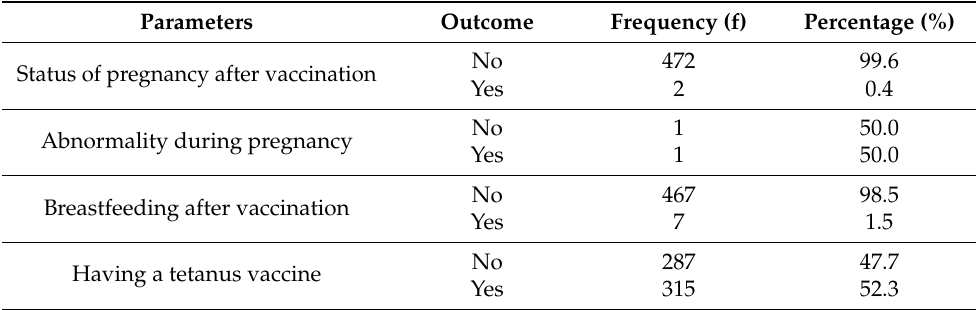
Table 2. Pregnancy and breastfeeding status after vaccination.